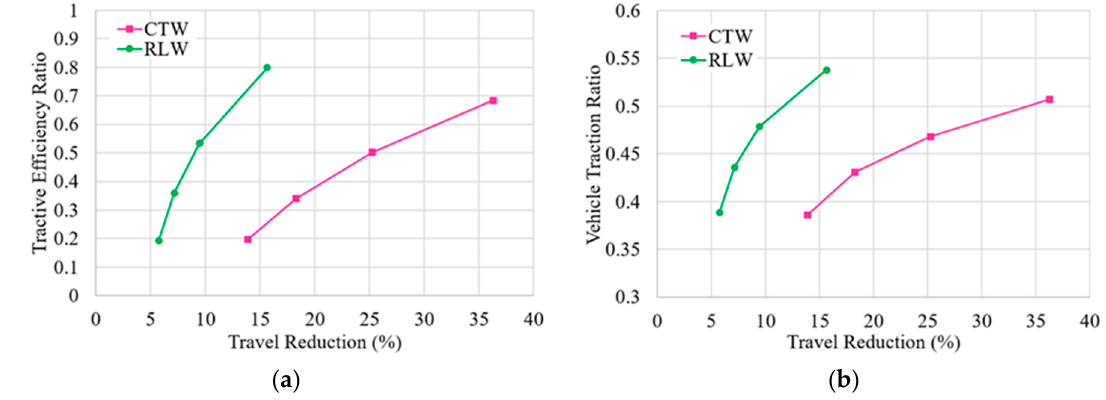
Figure 8. Comparison of traction performance and power transfer indices ( a ) traction efficiency and ( b ) vehicle traction ratio of a tractor with both traction